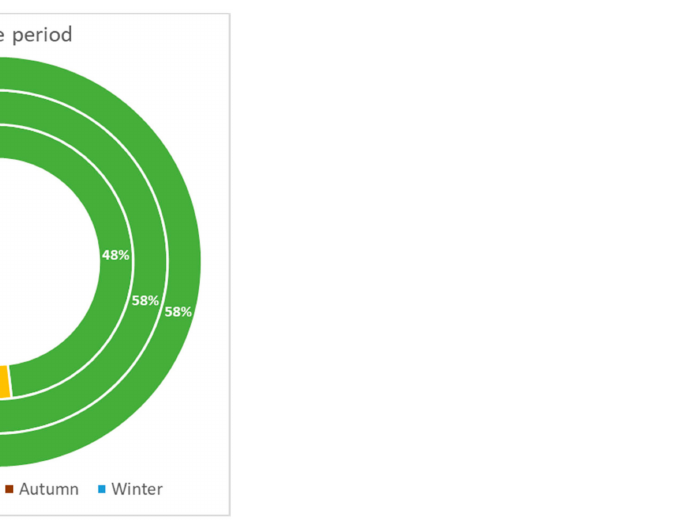
Figure 6. Example of number of peak months over return period 1 in 20 years per scenario—rivers within Elbe basin; catchment size: inner circle—451 km 2 , middle circle—1157 km 2 , outer circle—41,831 km 2 .